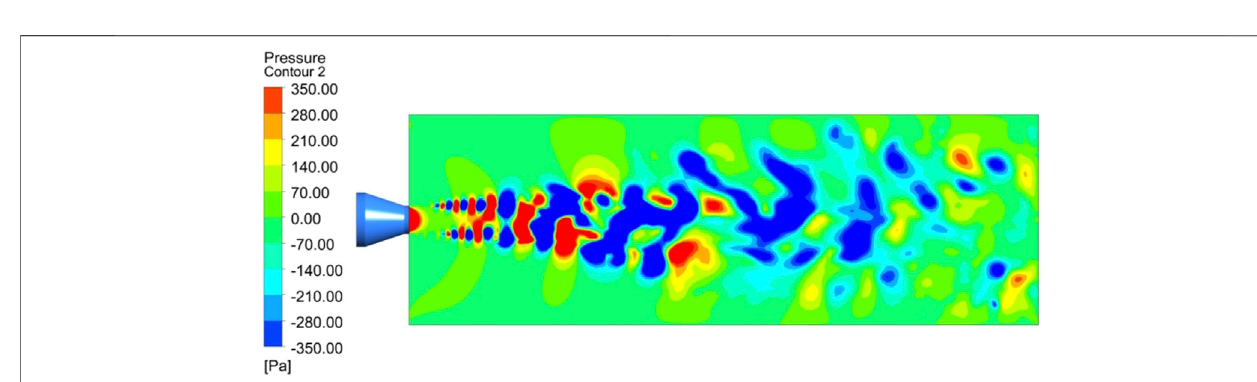
FIGURE 6 | Pressure distribution in the wake of water jet propulsion.